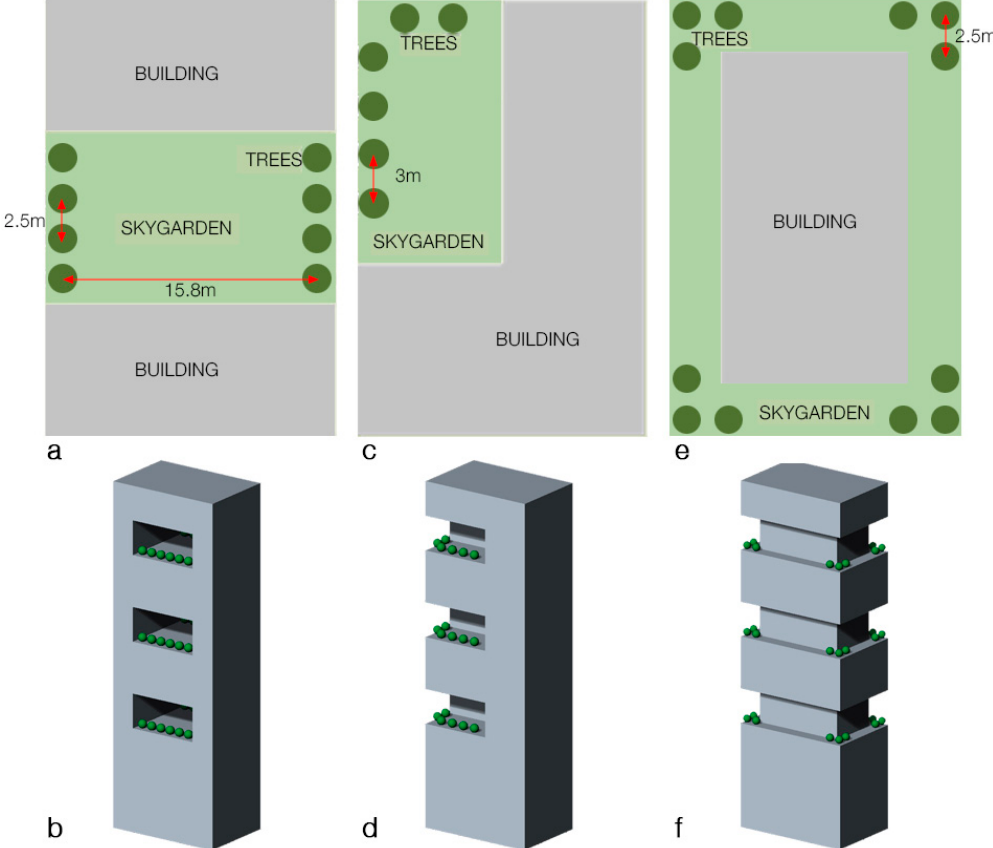
Figure 4. Sky gardens model and plan showing tree arrangement; ( a ) typical plan of central type, ( b ) simulation model of central type, ( c ) typical plan of corner type, ( d ) simulation model of corner type, ( e ) typical plan of periphery type, ( f ) simulation model of periphery type.